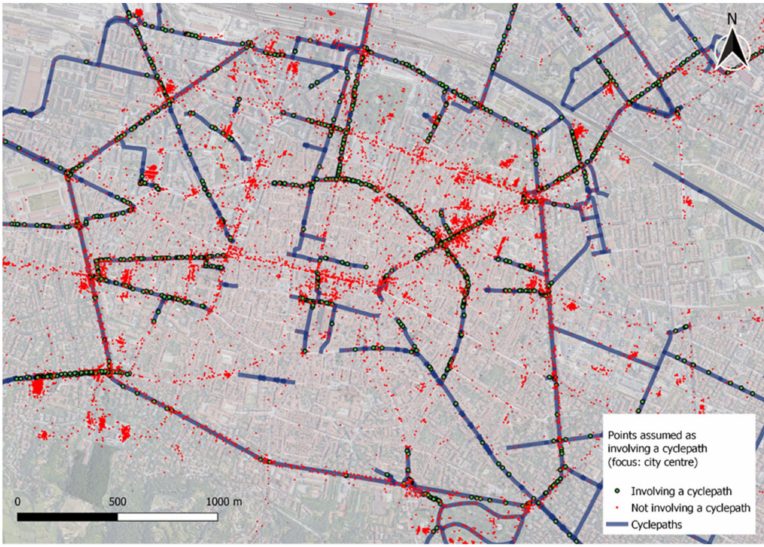
Figure 8. Cycle path usage; records involving/not involving cycle paths.